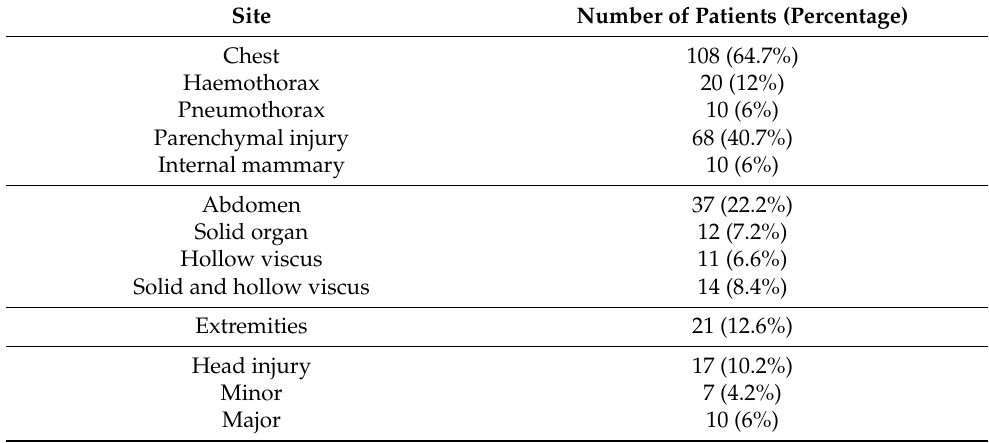
Table 2. Additional associated injury sites.